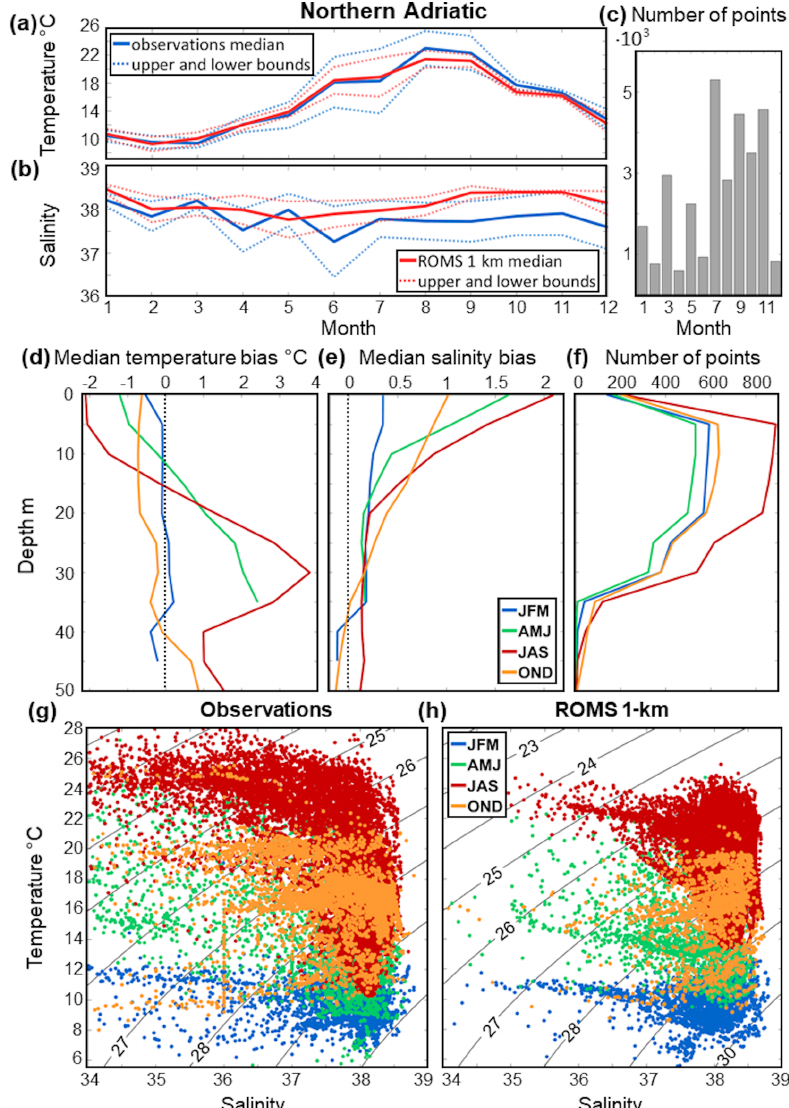
Figure 8. Northern Adriatic subdomain. Monthly climatology of AdriSC 1km and in situ (a) median temperature, (b) median salinity, and their variabilities (i.e. upper and lower bounds defined as ± MAD) as well as (c) the number of observations per month. Seasonal variations of the (d) temperature and (e) salinity biases between the AdriSC ROMS 1km model and observations depending on the depth as well as (f) the number of observations per depth. Seasonal T – S diagrams for (g) the CTD observations and (h) the AdriSC ROMS 1km model with potential density anomaly (PDA)